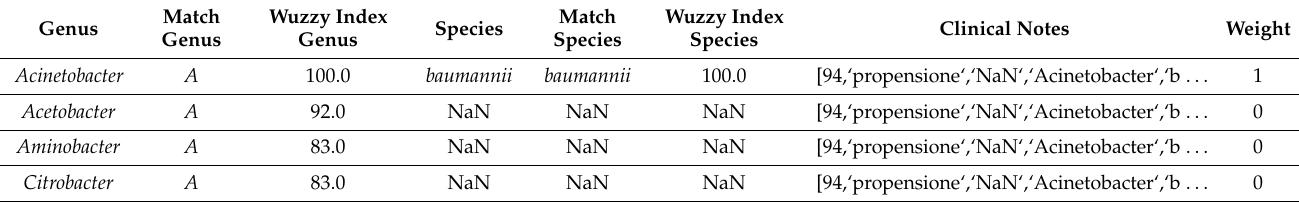
Table 1. Example of the system output returned when the input was “Gram negativi profilo pro- teomico riferibile ad A baumannii . Propensione di A baumannii alla pan-resistenza eccetto colistina (Microorganismo alert)”. The displayed columns correspond to the genus from the vocabulary, the specific word or character in text which the genus matches to, the genus Wuzzy similarity index, the species from the vocabulary, the word in text which the species matches to, the species Wuzzy similarity index, the clinical note divided into tokens, and the weight